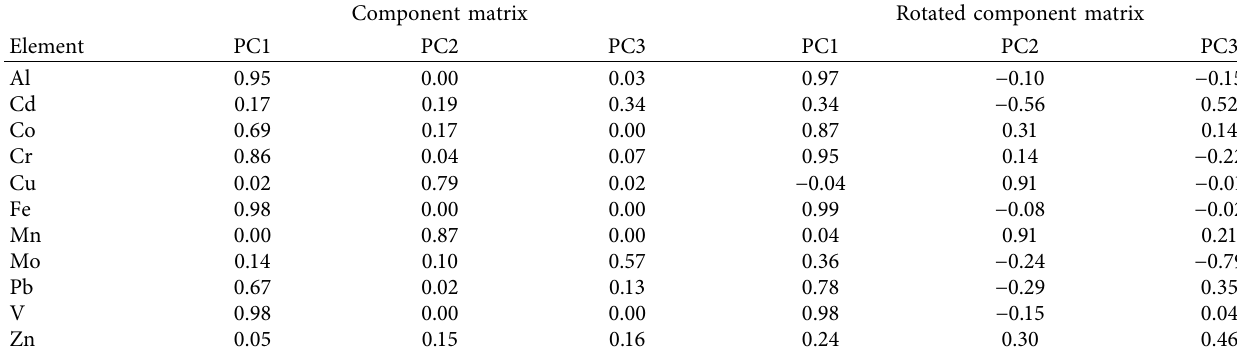
Table 7: Component